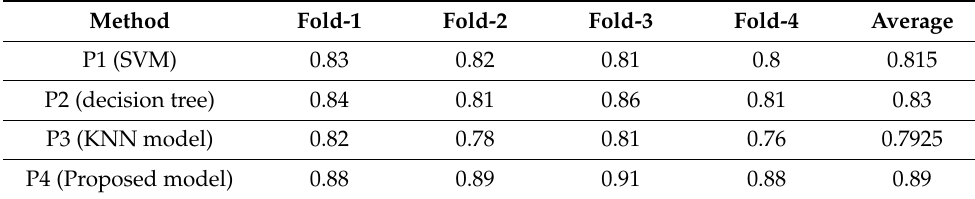
Table 4. Specificity of the proposed predictive model with other models.